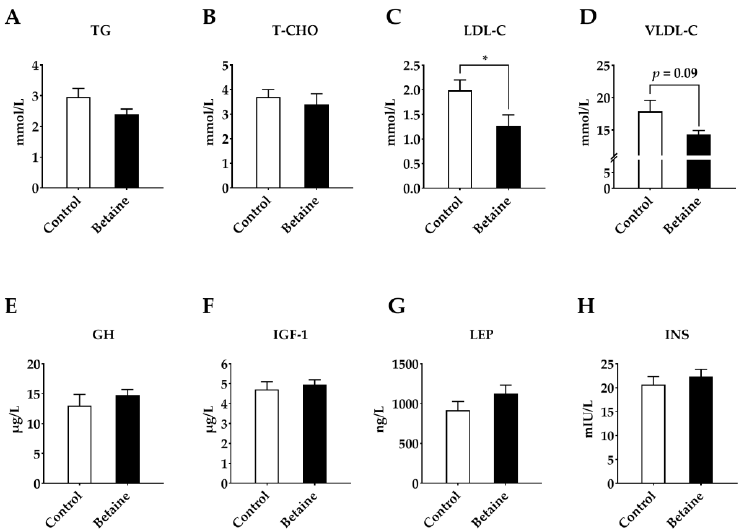
Figure 3. Effects of betaine on serum biochemical parameters and hormones in growing-finishing pigs. ( A ) TG, total triglycerides; ( B ) T-CHO, total cholesterol; ( C ) LDL-C, low-density lipoprotein cholesterol; ( D ) VLDL-C, very low-density lipoprotein cholesterol; ( E ) GH, growth hormone; ( F ) IGF-1, insulin-like growth factor 1; ( G ) LEP, leptin; ( H ) INS = insulin. * p < 0.05 versus the control